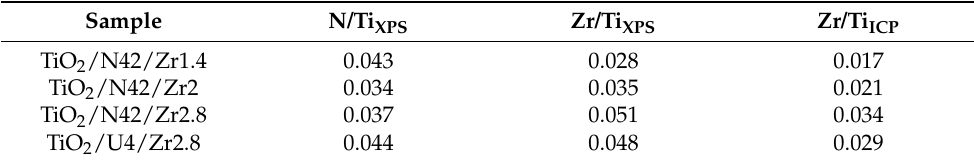
Table 3. Dopant molar ratios in TiO 2 -based